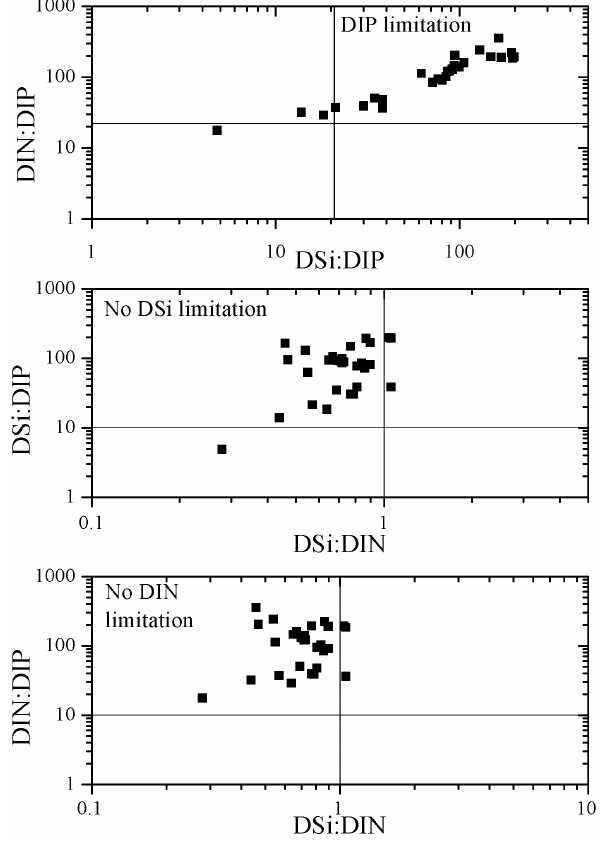
Fig. 11. Nutrient ratios diagrams for Badum coastal water samples suggesting phosphorus limitation.